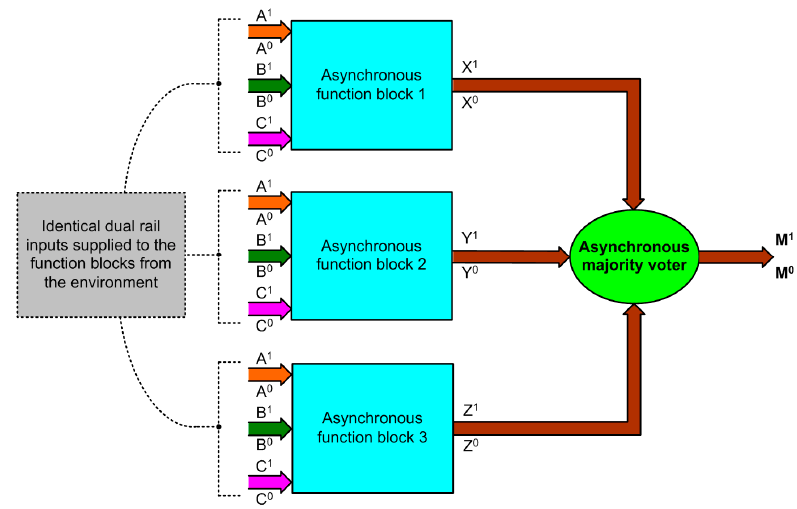
Figure 3. Asynchronous TMR implementation utilizing dual-rail encoding.